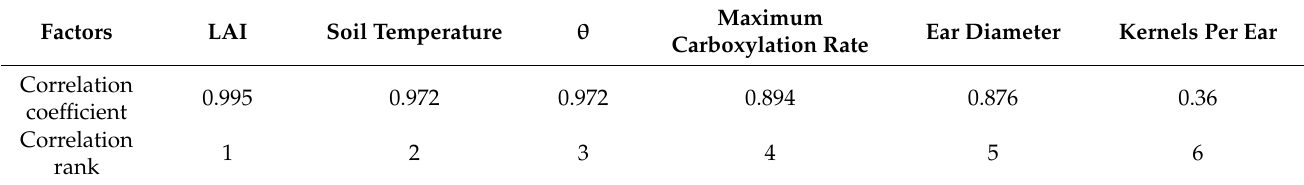
Table 6. Grey correlation analysis of yield and influencing